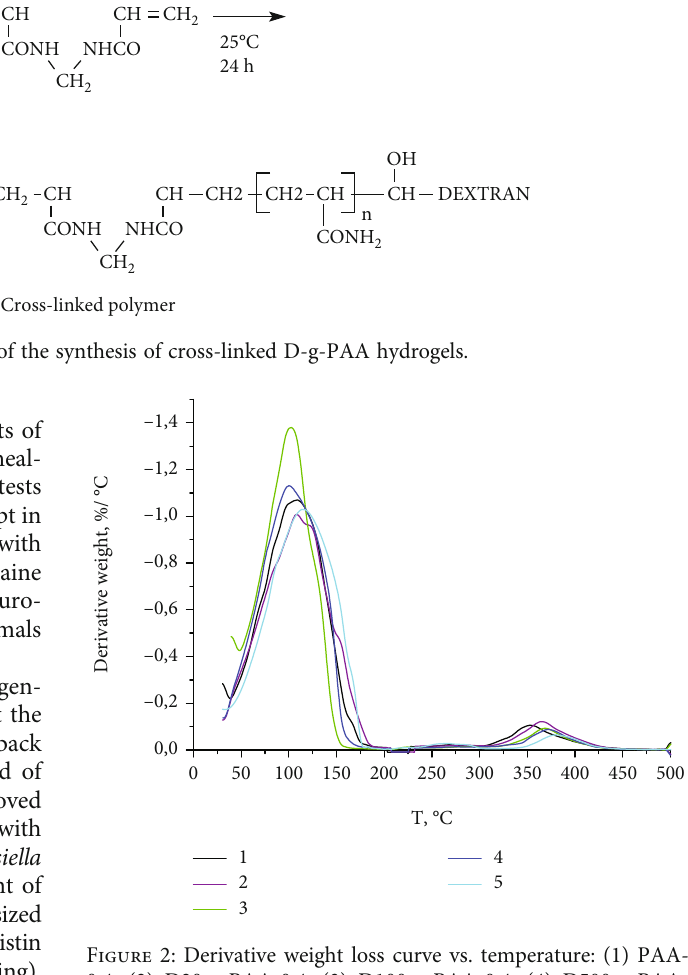
Figure 2: Derivative weight loss curve vs. temperature: (1) PAA- 0.4, (2) D20-g-PAA-0.4, (3) D100-g-PAA-0.4, (4) D500-g-PAA- 0.4, and (5) DS500-g-PAA-0.4